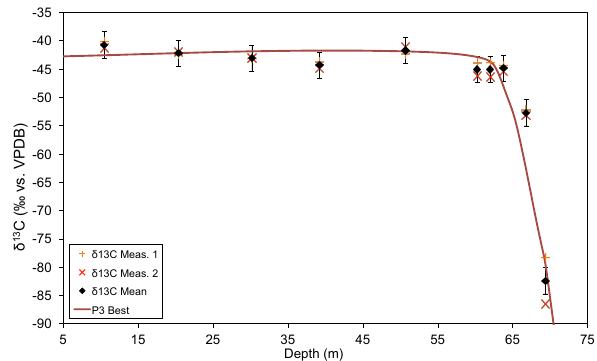
Fig. 4. Vertical profiles of δ 13 C (CFC-12) (‰, vs. VPDB) from firn air at S2 drill site, NEEM, Greenland, for independent measure- ments ( δ 13 C Meas. in legend) and 2 and mean values. Error bars represent 98% confidence intervals with respect to the mean. The 3rd degree polynomial firn air model best scenario (red trace) is in- cluded for reference.